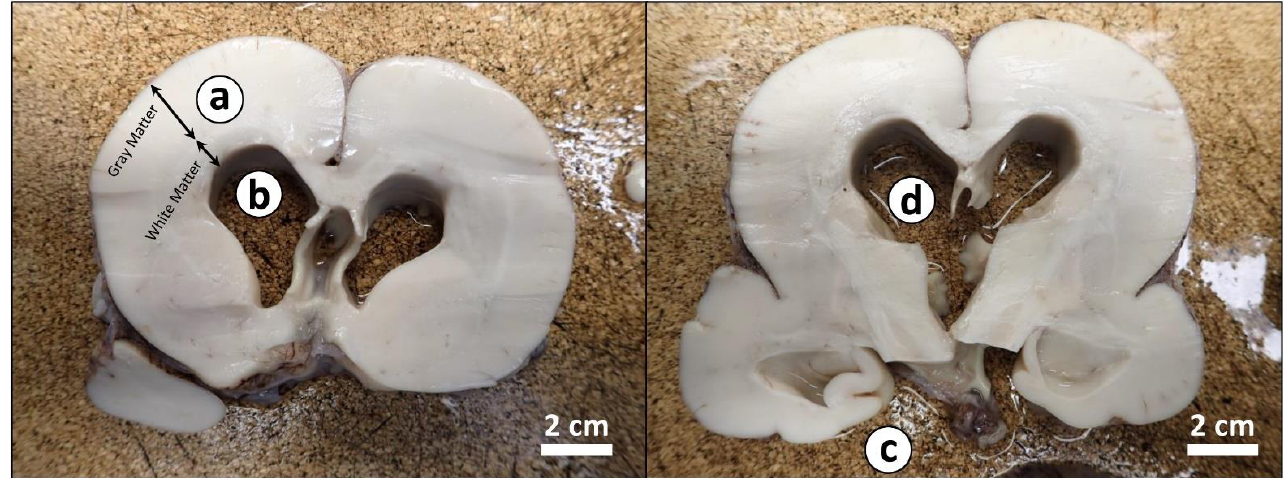
Figure 5. Coronal sections of the cerebrum. The cross sections revealed diminishing white matter in all cerebral hemispheres ( a ). The ventricular system was significantly dilated ( b ). The hippocampi were small bilaterally ( c ). The interhemispheric fissure disclosed partial absence of the corpus callosum ( d ).